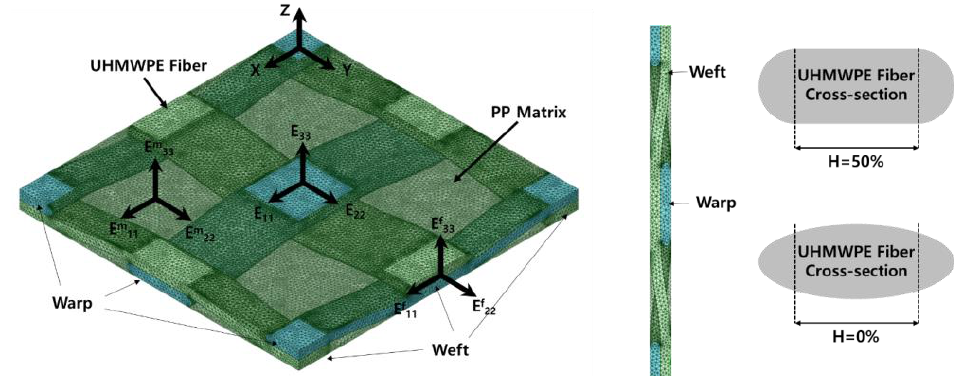
Figure 1. Three-dimensional model and tensor notations.